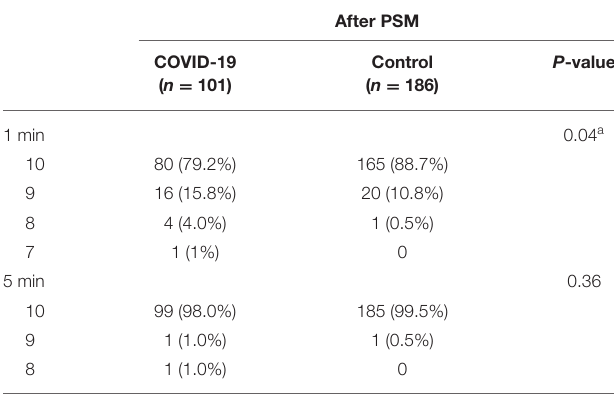
TABLE 5 | Neonatal Apgar scores in COVID-19 group vs. Control group after propensity score matching (PSM).